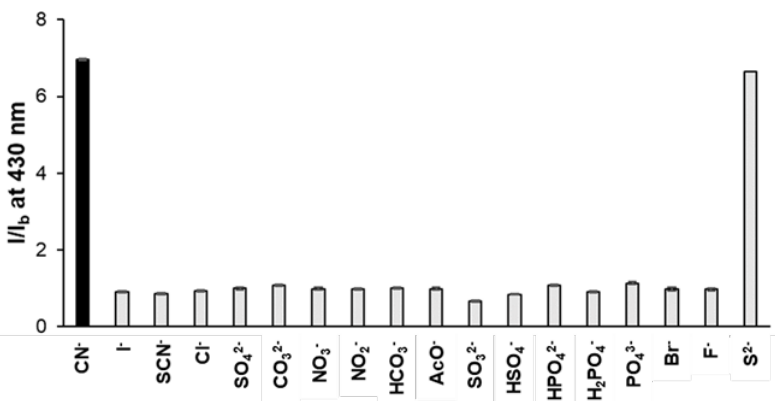
Figure 5. Fluorescence recovery (I / I b ) for 0.1 µ M sensor A (a 0.2 µ M 1 + 0.1 µ M 3 + 4 µ M Cu 2 + mixture) in the presence of 25 µ M of various anions; the solvent used is 0.5wt% Triton X-100 in deionized water and λ EX = 350 nm.